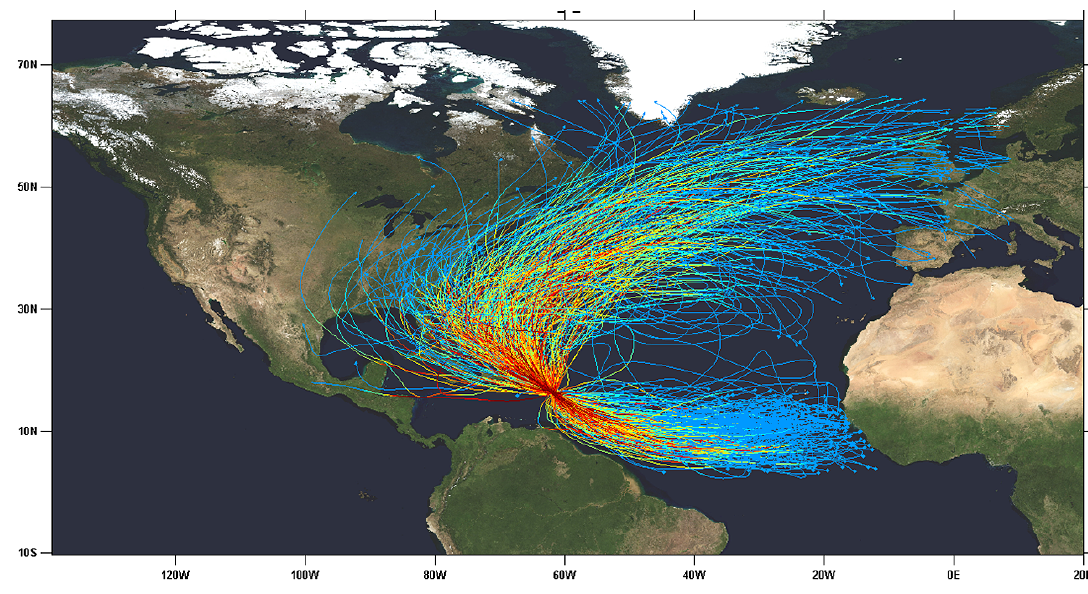
Figure 5. Storm tracks obtained for the 300 strongest events of the second data set (50000 years).